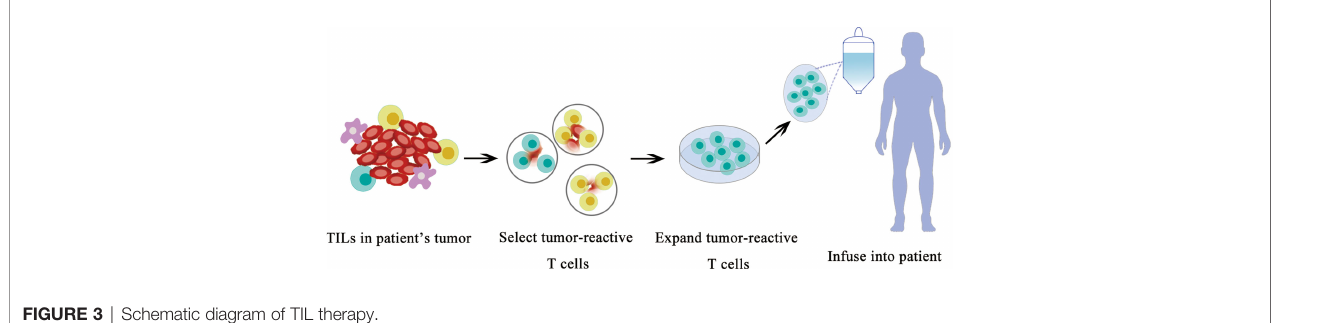
FIGURE 3 | Schematic diagram of